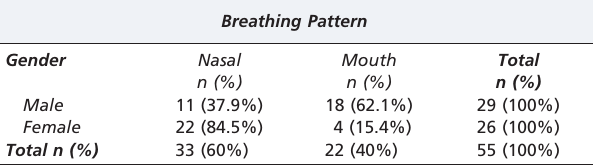
Table 1 - Numbers and percentages of mouth breathers and nasal breathers according to gender.